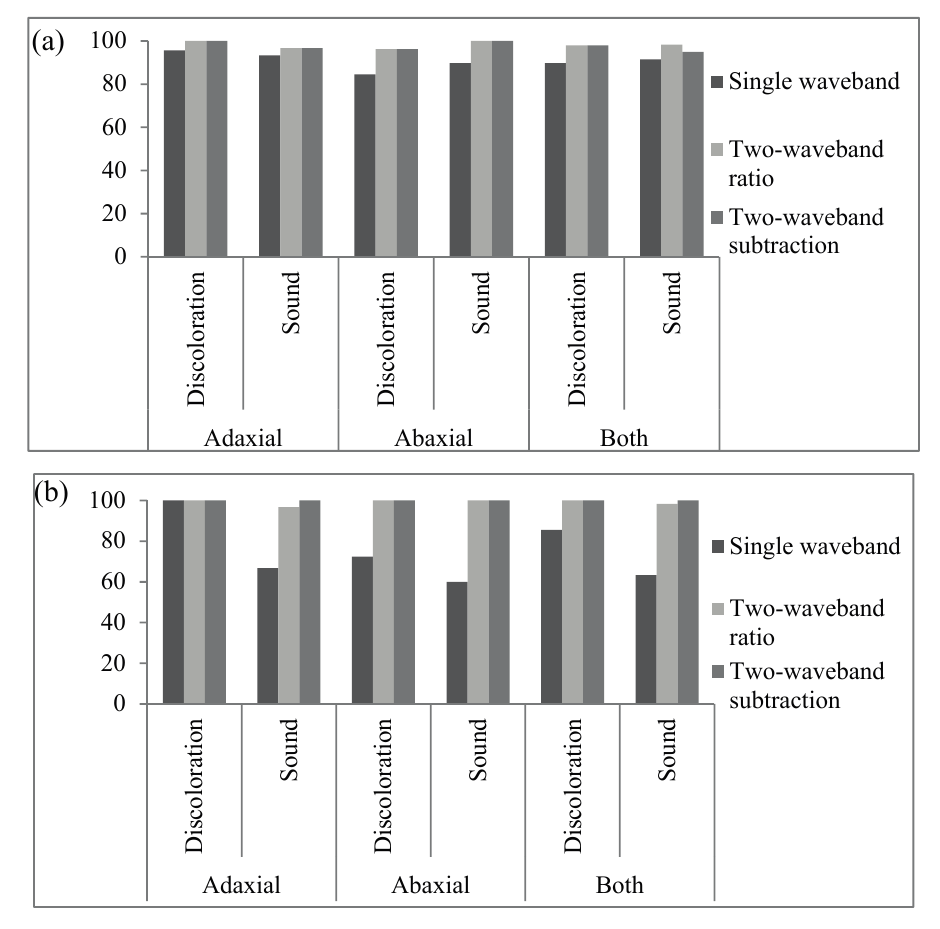
Figure 3. Classification accuracy of adaxial surface, abaxial surface and both surfaces using a single waveband algorithm and a combination of a two-waveband algorithm and average spectra: ( a ) calibration (Set A) and ( b ) validation (Set